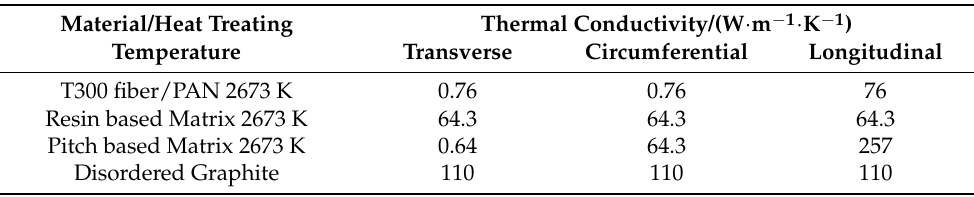
Table 1. Thermal conductivities of the constituent